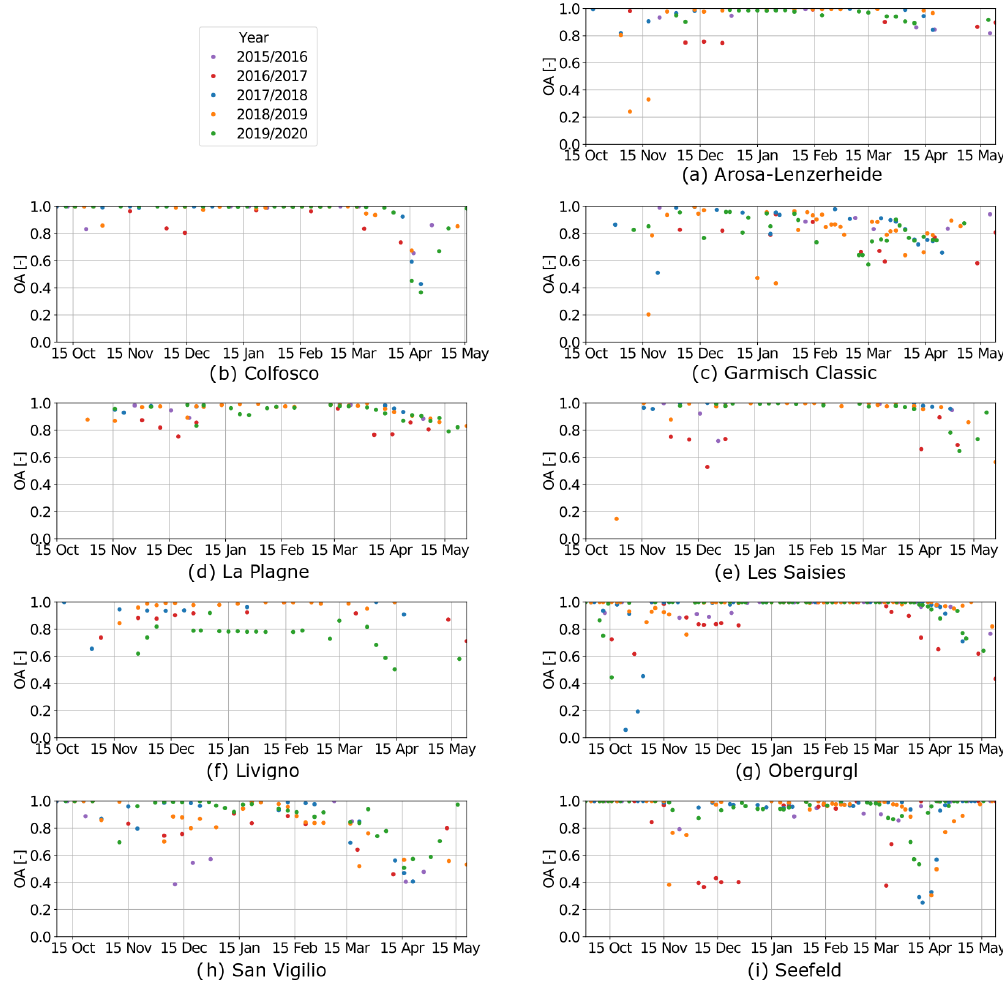
Figure A2. Overall accuracy trends over time between simulation and S2 data for each ski resort for machine-made snow on the pistes. We considered images ranging from the winter season 2015/16 to the winter season 2019/20, except for Livigno, where simulations are not available for the first season 2015/16 due to gaps in the meteorological forcing